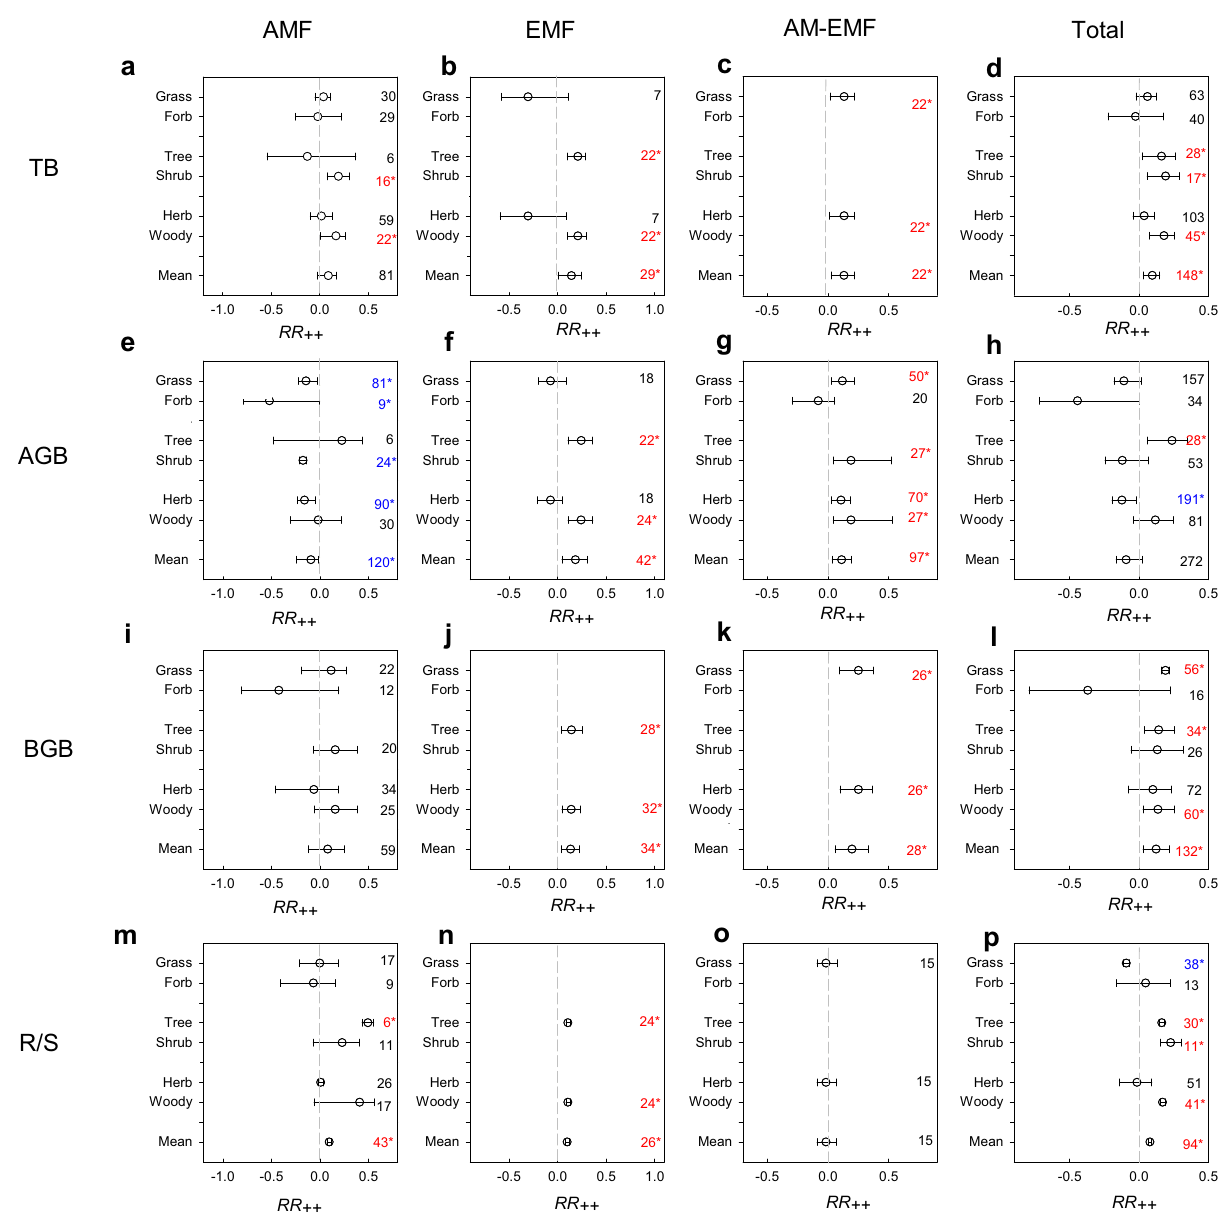
Fig. 5 | Weighted response ratio of variables to warming in different biomes. a – d Weighted response ratio ( RR ++ ) of plant total biomass (TB). e – h RR ++ of abovegroundbiomass(AGB). i – l RR ++ ofbelowgroundbiomass(BGB). m – p RR ++ of root:shoot ratio (R/S). AMF ( a , e , i , m ), EMF ( b , f , j , n ), and AM-EMF ( c , g , k , o ) indicate biomes with dominant root symbiosis of arbuscular mycorrhizal fungi (AMF), ectomycorrhizal fungi (EMF), mixed AMF and EMF (AM-EMF), respectively (Supplementary Data 1). The numbers inside plots indicate sample sizes. Only the subgroups with a sample size >5 were included. The error bars indicated 95%